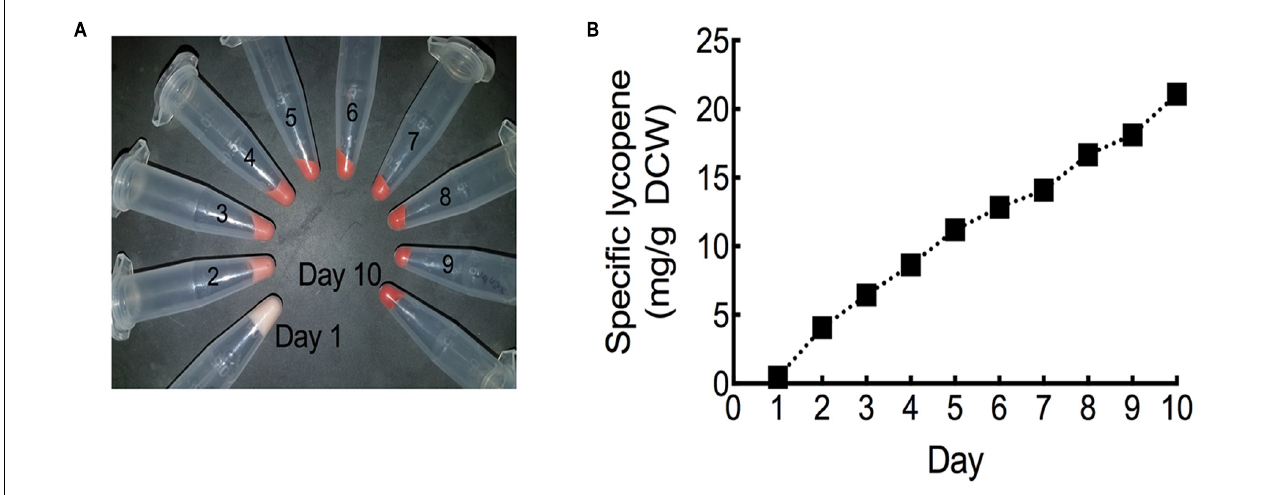
FIGURE 10 | Lycopene production in fed-batch bioreactor. (A) Cell pellets taken from each day of bioreactor culture post-inoculation. Red coloration is due to lycopene production. (B) Specific lycopene production at each day of bioreactor culture post-inoculation. Data represents technical triplicates of a single bioreactor